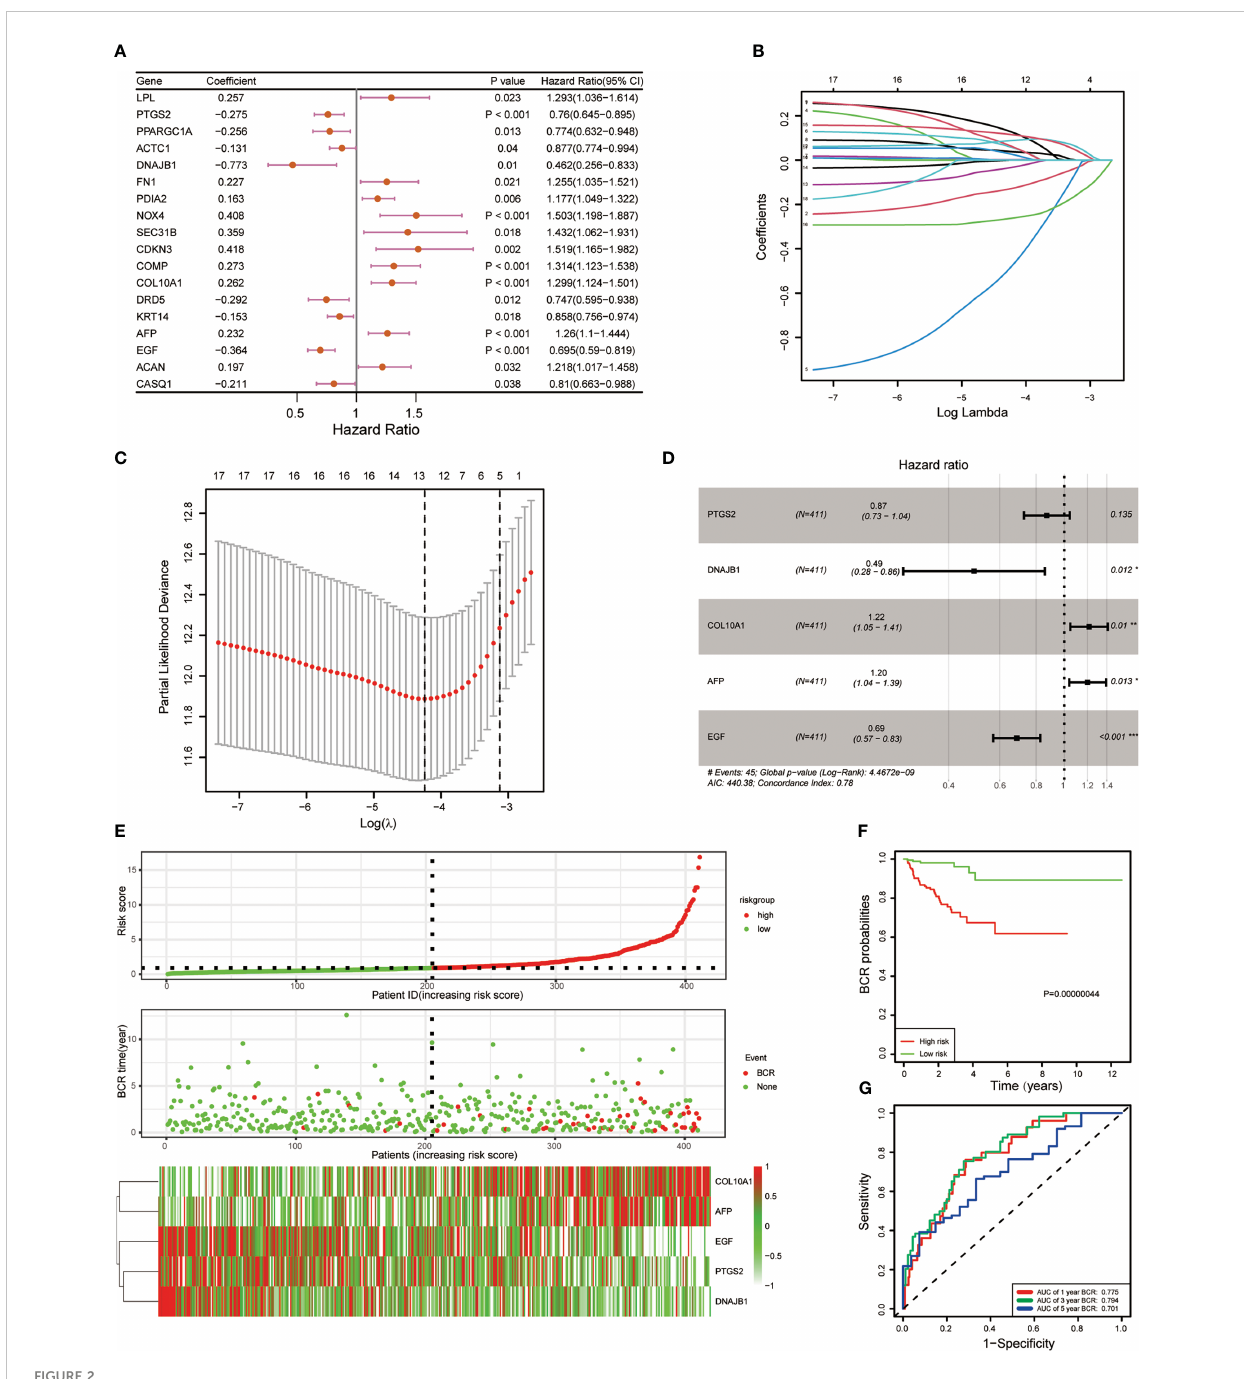
FIGURE 2 Development of fi ve endoplasmic reticulum stress-related gene BCR signature. (A) Univariate Cox regression revealed 18 ERS-related genes associated with BCR. (B) Eighteen ERS-related genes were penalized by LASSO Cox regression analysis. (C) Tenfold cross-validation for the optimal parameter selection in the LASSO Cox regression. (D) A fi ve-gene model was constructed with a stepwise regression model using the Akaike Information Criterion (AIC) method. (E) The risk score distribution, BCR status, and fi ve-gene expression trend in the TCGA PRAD dataset. (F) KM survival curve of the fi ve-gene signature in the TCGA PRAD dataset. (G) ROC curves for BCR-free survival prediction models at 1, 3, and 5 years. (*p < 0.05; **p < 0.01; ***p <